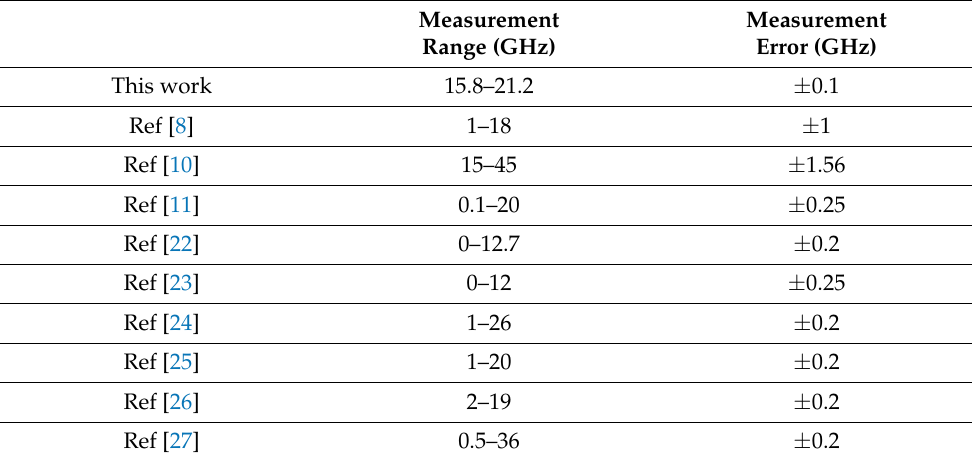
Table 1. Performance Comparison.